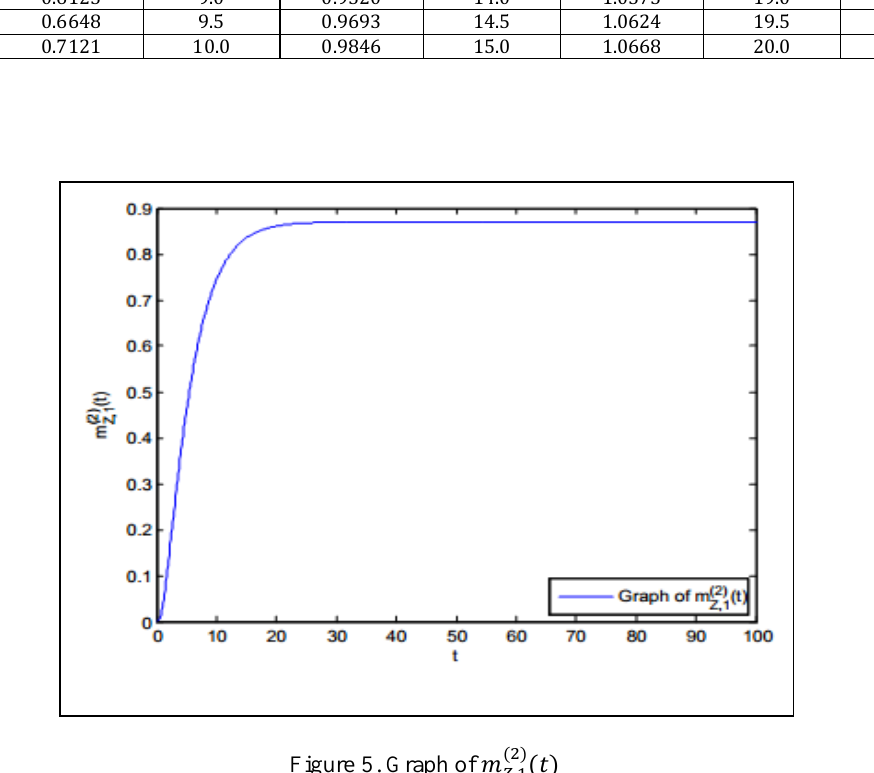
Figure 5. Graph of 𝑚 𝑍,1(2)